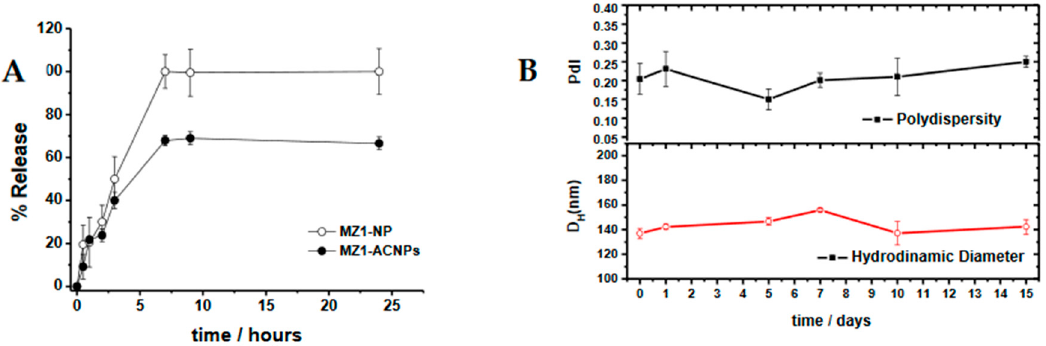
Figure 2. ( A ) Physical stability of ACNPs. ( B ) In vitro release profiles of MZ1-NPs and MZ1-ACNPs at pH 7.4. Data are expressed as mean ± s.e.m. from at least three independent experiments.